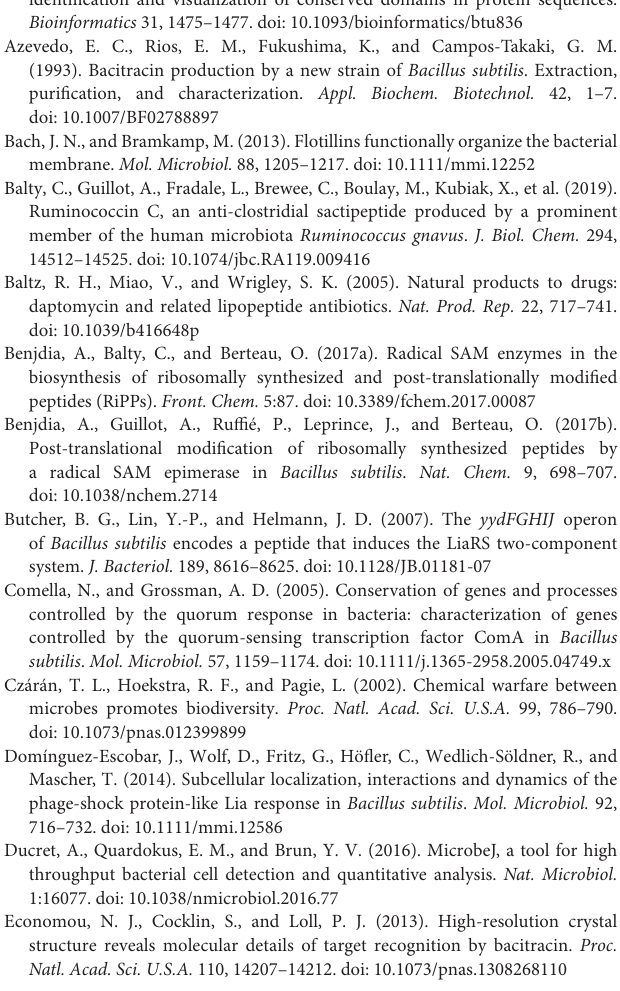
values normalized over optical density. Measurements were taken every 5min over a time period of 15h. Growth in full medium of P liaI - lux strains in the wild type background and individual yyd mutants. Figure S2 | Growth curves of B. subtilis wild type in full medium. Growth in full media of B. subtilis wild type, challenged with various concentrations of YydF ∗ after 1h incubation. Measurements were taken every 5min over a time period of 15h. Figure S3 | Effect of YydF ∗ on B. subtilis membranes lipid packing state. Overlay of phase contrast and fluorescence images of B. subtilis cells stained with the membrane dye nile red after exposure to 4 µ M YydF ∗ for 5min. Figure S4 | Effect of YydF ∗ on B. subtilis membranes lipid packing state. Overlay of phase contrast and fluorescence images of B. subtilis cells stained with the membrane dye nile red after exposure to 4 µ M YydF ∗ for 20min. Table S1 | Strains, primers and